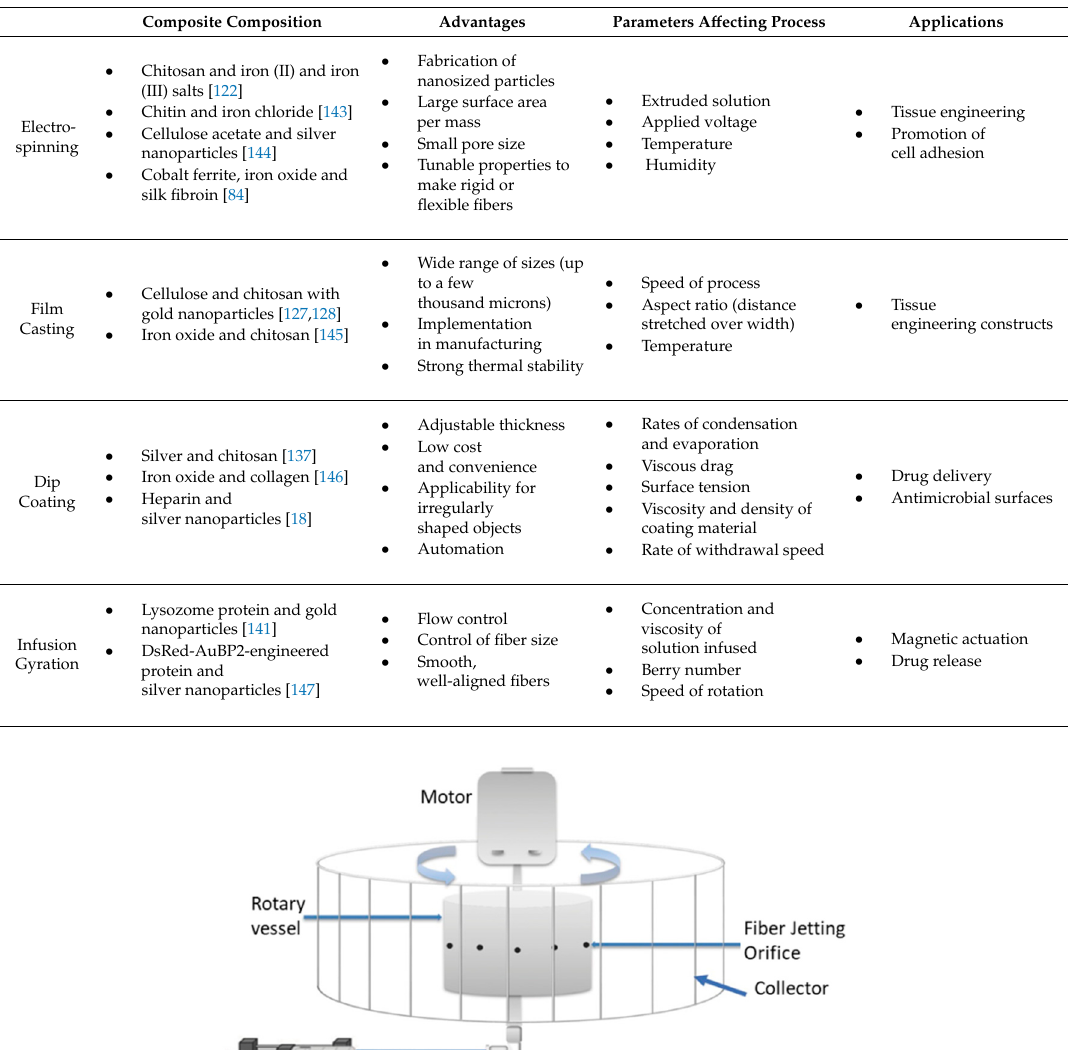
Table 2. Advantages, parameters, and applications of the common protein or polysaccharide based magnetic material fabrication methods. Source [14,18,84,108–111,118,119,124–128,132,134–137,139].